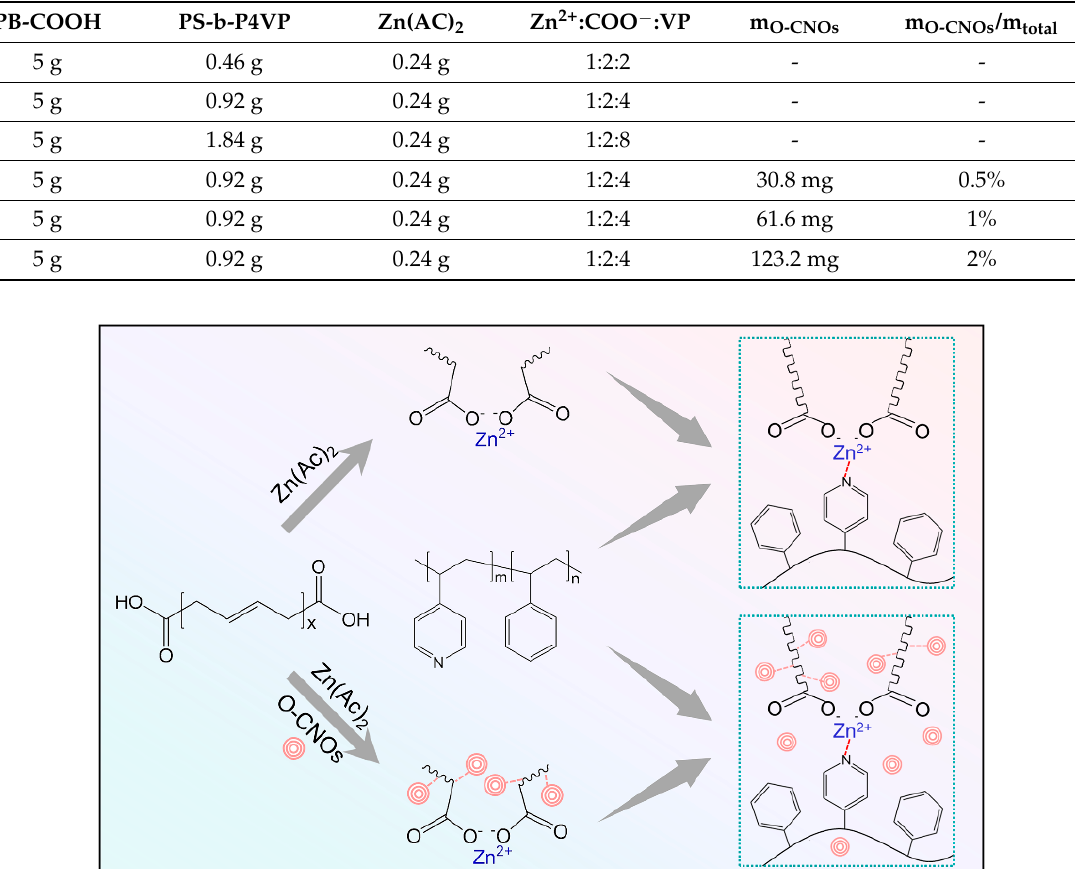
Table 1. Component polymers ratio table.